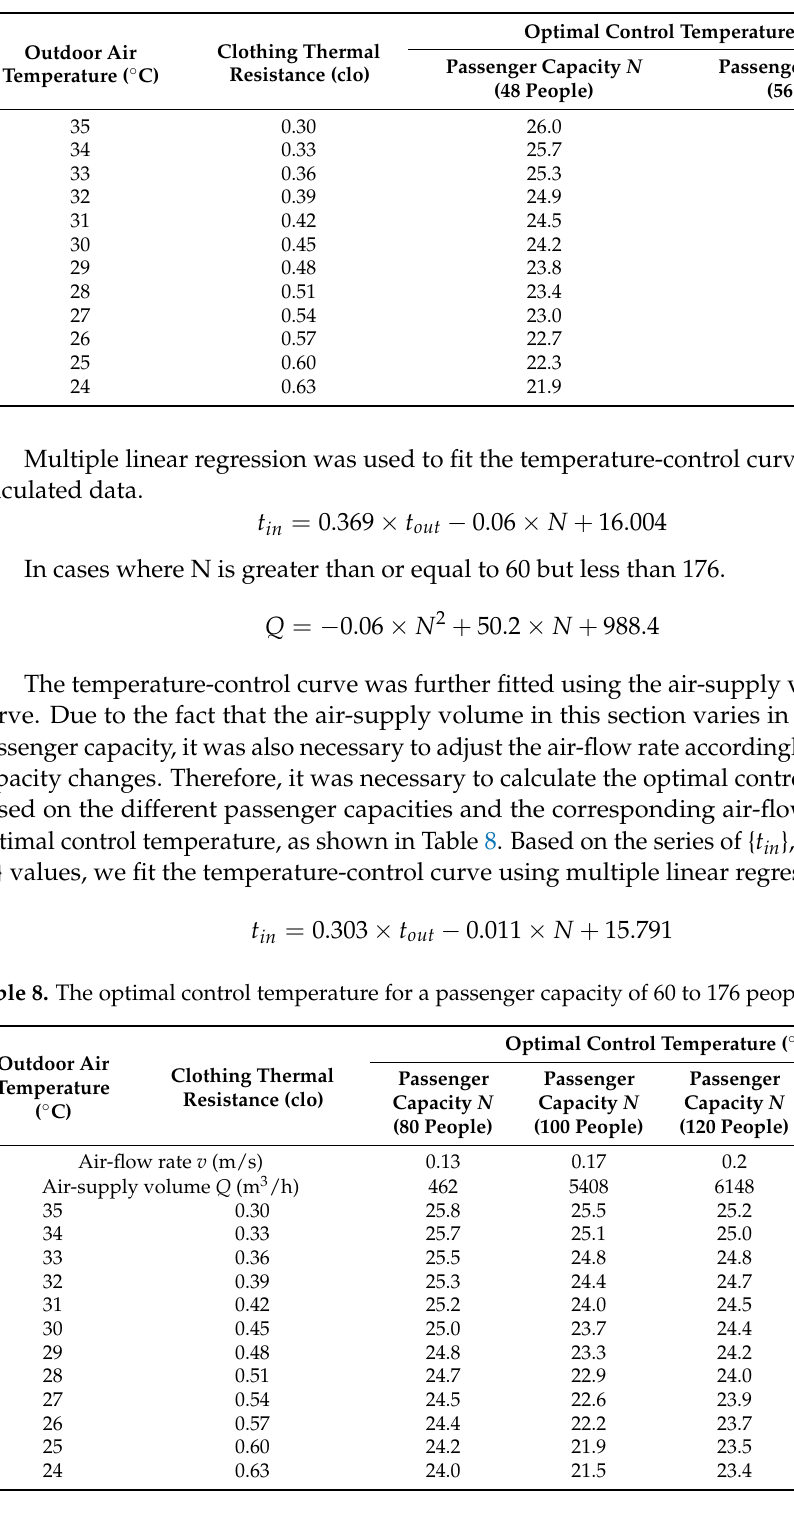
Table 7. The optimal control temperature for a passenger capacity of 0 to 60 people.